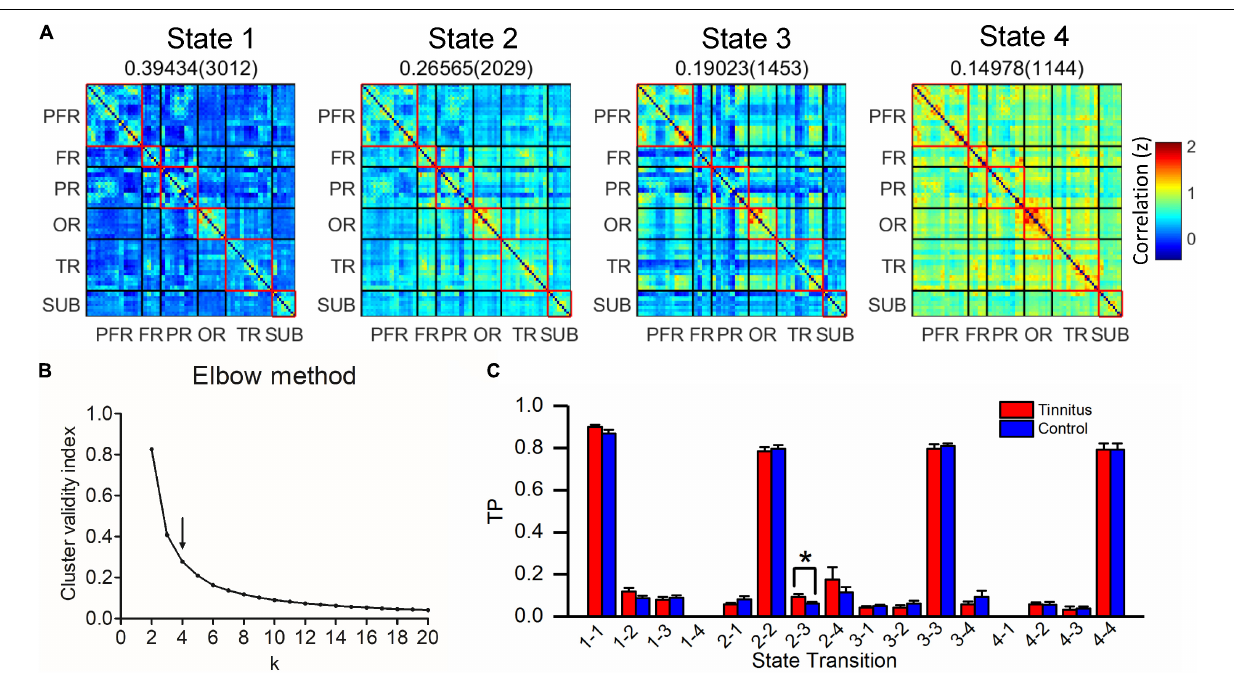
FIGURE 5 | Clustering analysis of four states in chronic tinnitus patients before acupuncture and normal subjects. (A) Four states (centroids) from clustering analysis. The total number (in brackets) and proportion of occurrences are listed above each state. (B) Elbow criterion. The arrow represents the optimal k value. k , the number of clusters; Cluster validity index, calculating as the ratio of within-cluster distance to between-cluster distance. (C) Comparison of TP between chronic tinnitus patients before acupuncture and normal subjects. FR, other regions of frontal lobe; PR, parietal regions; OR, occipital regions; PFR, prefrontal regions; SUB, subcortex regions; TP, transition probability; TR, temporal regions. * P <